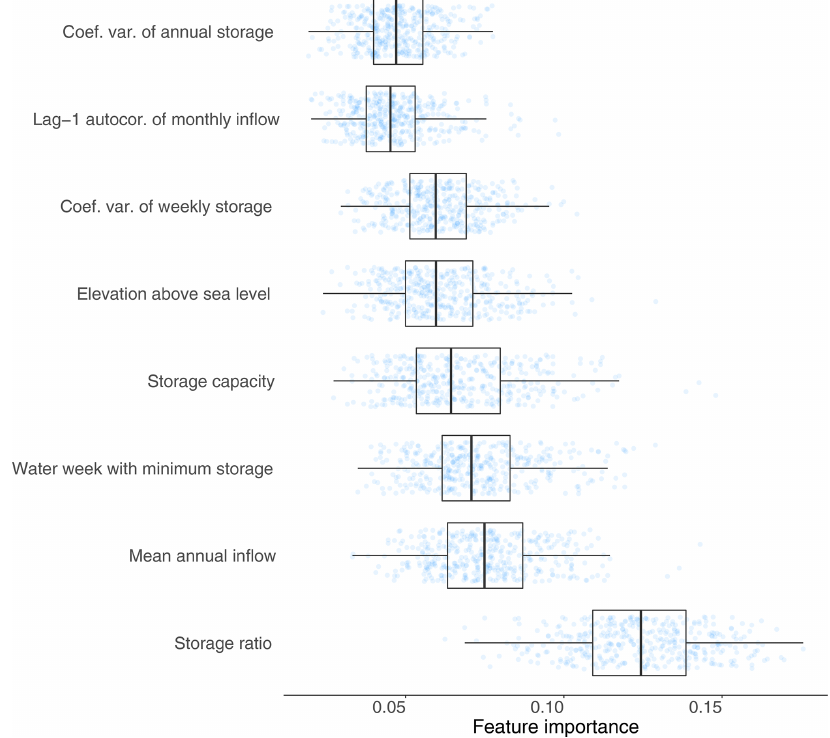
Figure 5. Distribution of feature importance across 400 random forests (eight features with the highest median importance shown). The distribution is created by bootstrapping the random forest classification model with resampled training and test data. Boxplots give the median and interquartile range. Table 1. Performance metrics for observed versus simulated daily release for two policies: “current week” (CW) neglects forecasts and instead uses piecewise release–availability functions trained on availability = storage + current inflow; “horizon curve” (HC) adopts the horizon curve and associated piecewise release–availability functions. Metrics assessed are the RMSE of daily releases, RMSE of annual maxima of the daily releases, RMSE of annual 90d minimum series, and Box–Cox transformed RMSE (TRMSE). Grand Coulee Lake Powell Shasta